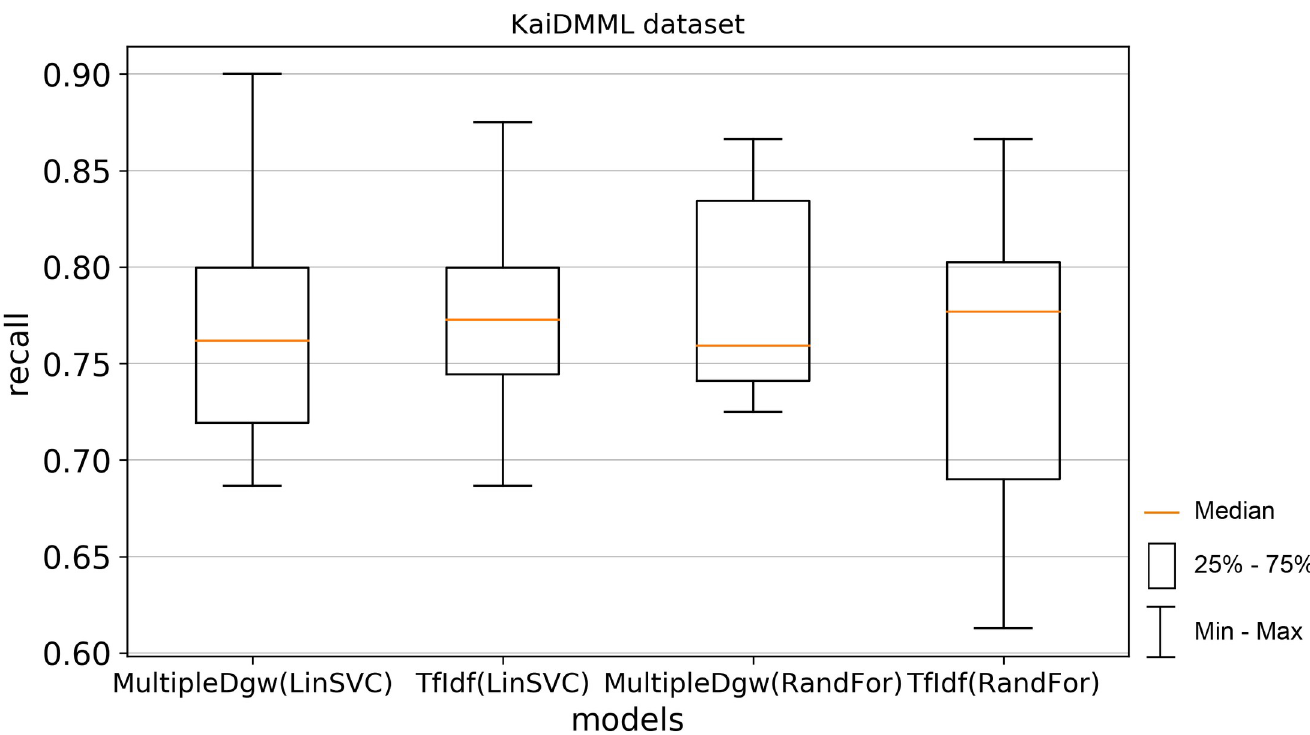
Fig 11. Boxplot for the model performance measurement—recall for dataset